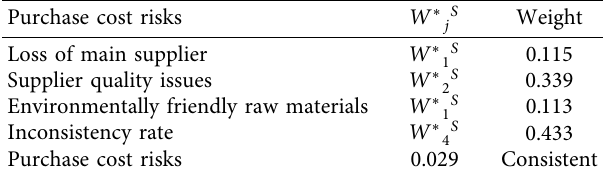
Table 8: Average weights of supply risk criteria.